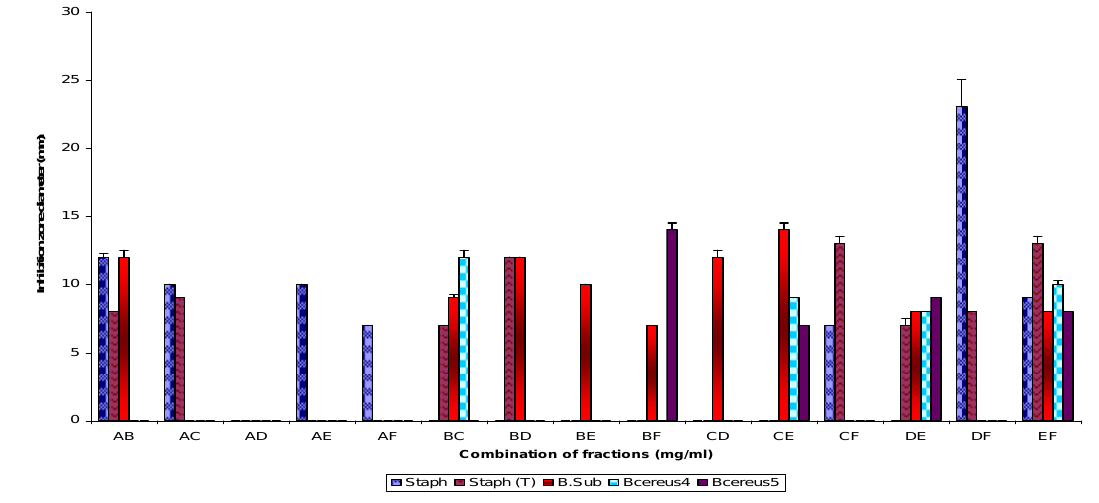
Figure 2. Antibacterial susceptibility pattern of the Gram positive bacterial test strains to combination of fractions Ti (A-F).